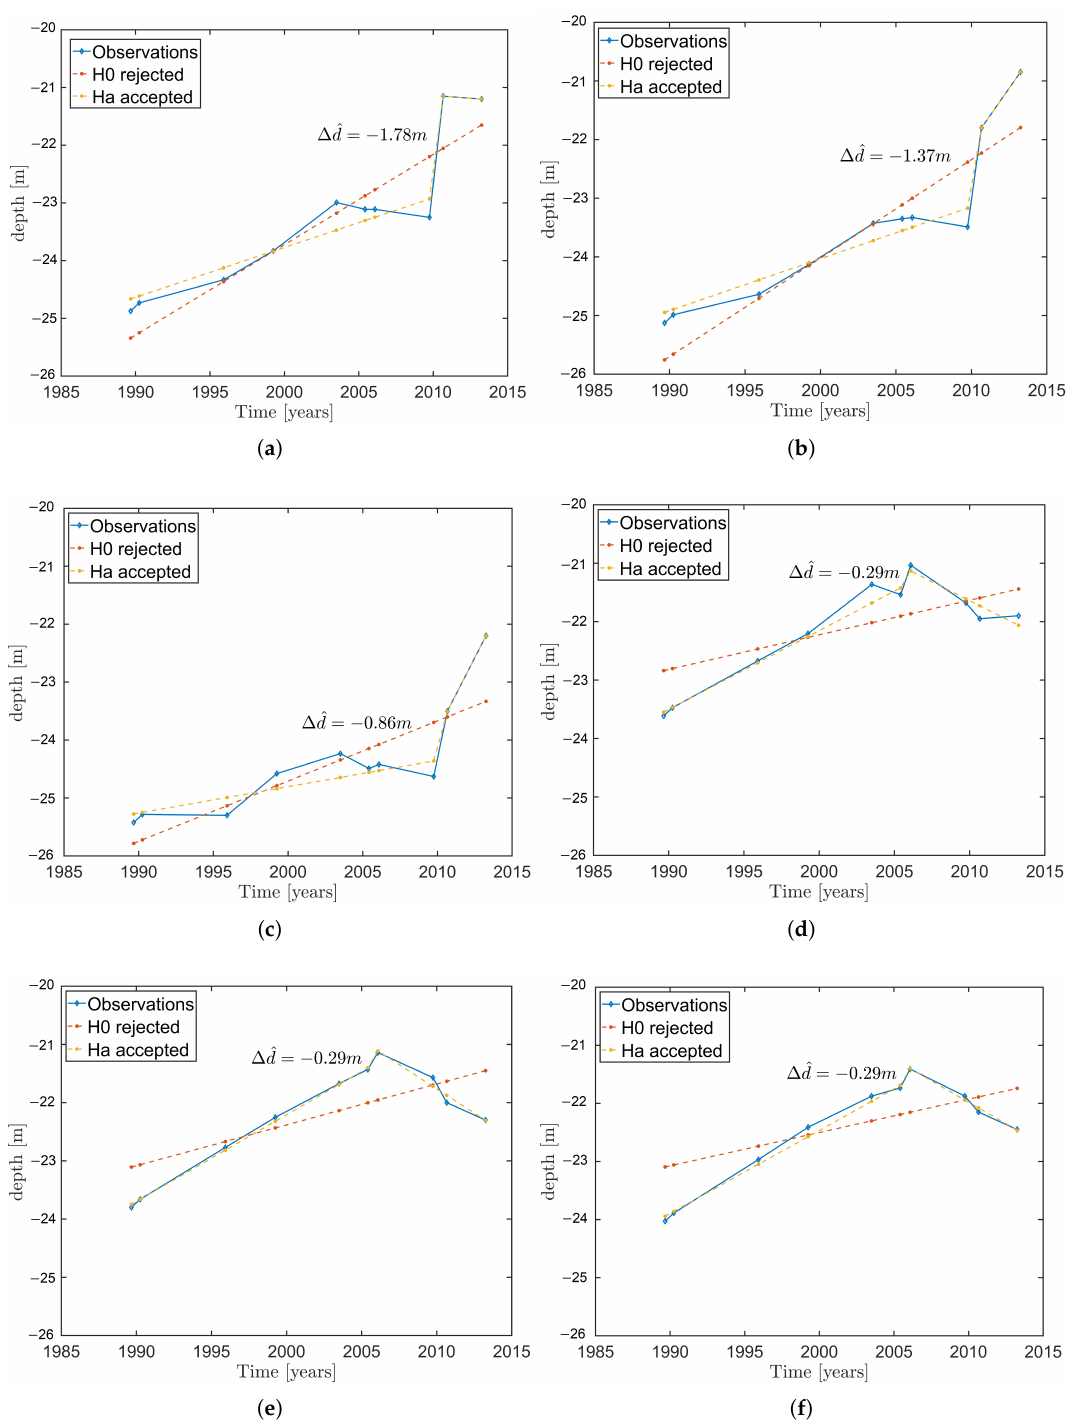
Figure 10. Visual inspection of the time series of nodes, numbered 1 to 6, as in ( a – f ), showing the accepted models where H a is accepted in favour of H 0